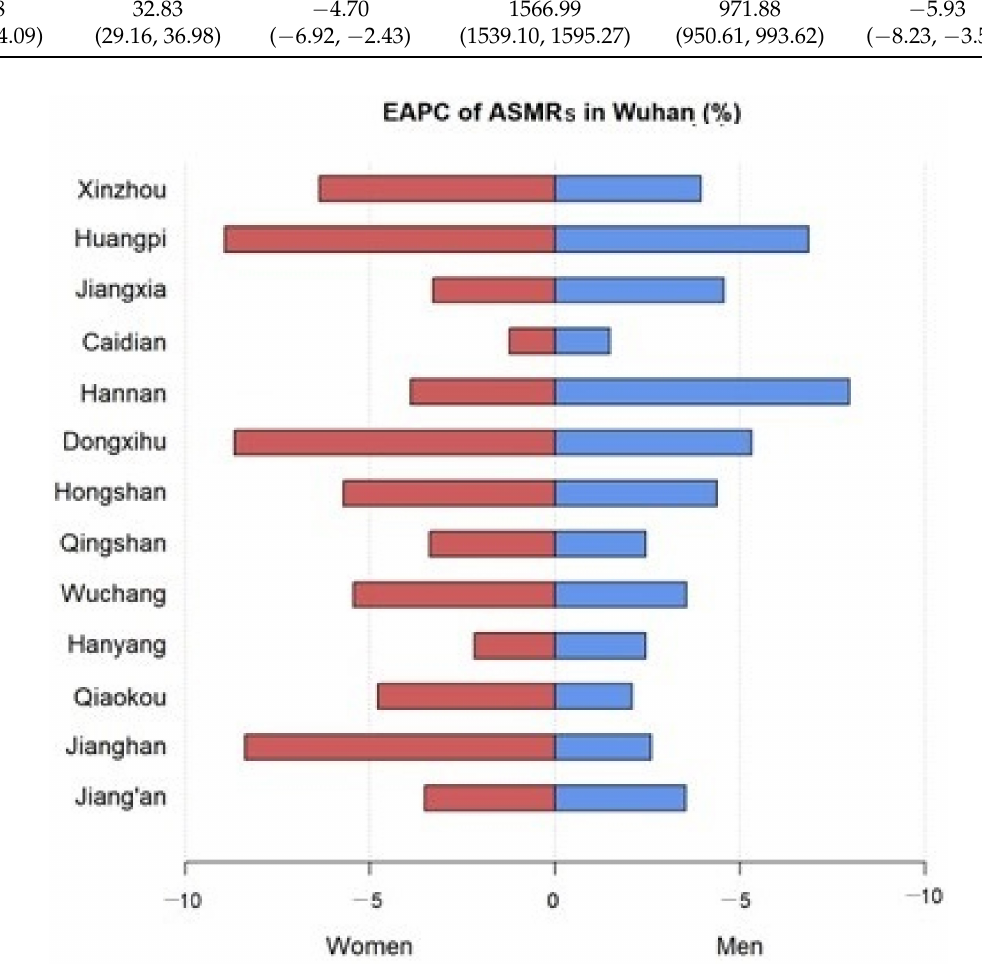
Figure 5. EPACs of ASMRs among the women and men in the districts of